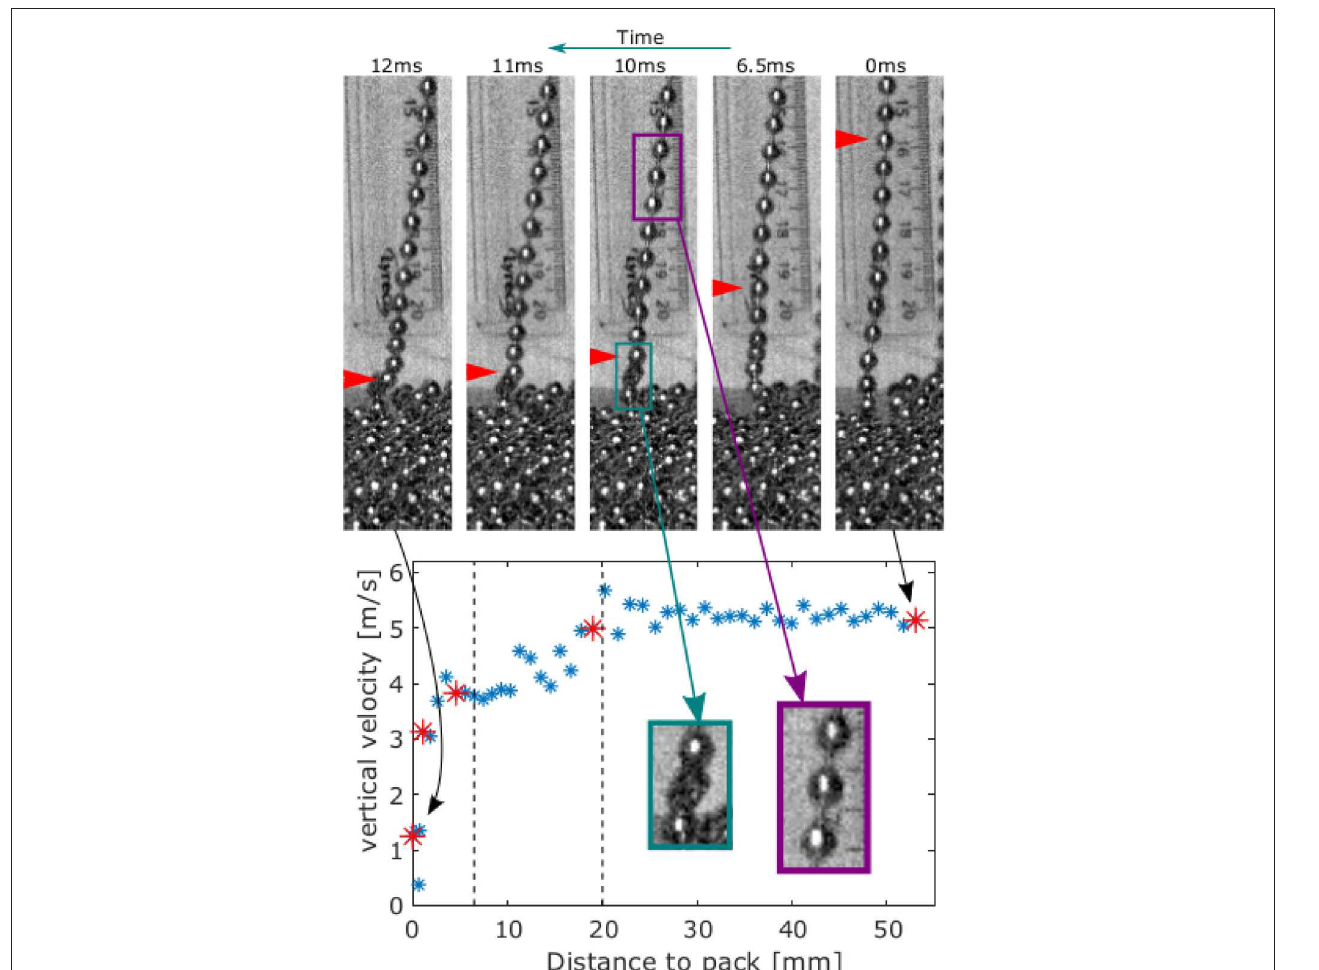
FIGURE 14 | Velocities measured at different heights above the floor. The graph shows how the upwards forces, coming from the interaction with the floor, slow down the beads. The rectangular frames illustrate how a group of three beads is compressed as it hits the packing. The rightmost vertical line shows where forces from the floor are observed to slow the chain down. The leftmost line denotes the distance a 0 , above which there can be no direct interaction with the underlying packing.